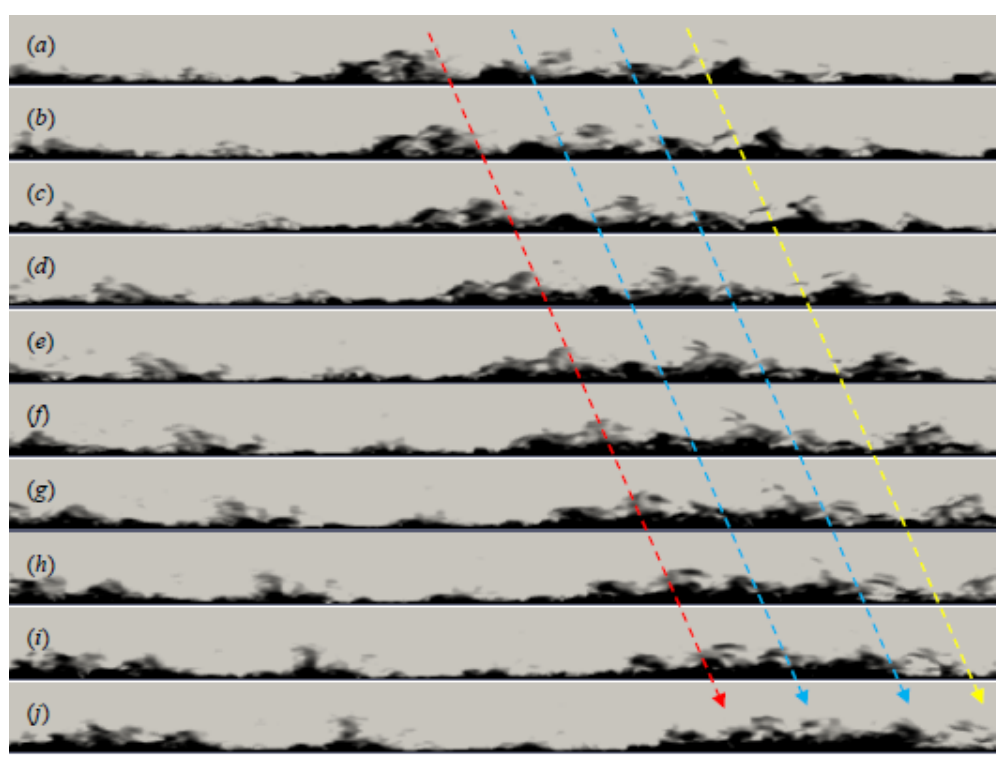
Figure 20. Evidence of the streamwise scale growth in xz plane. Subfigures a to j represent the time evolution of flow field.